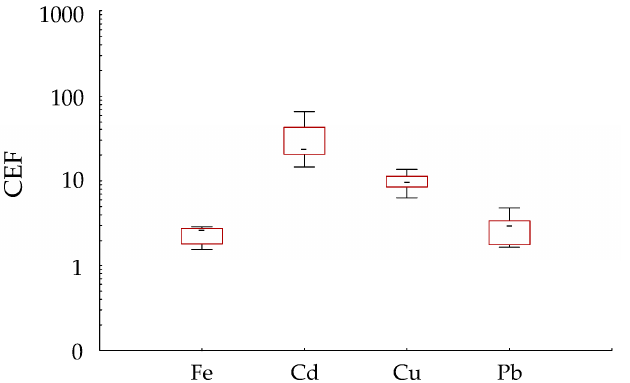
Figure 4. Box-and-whisker plots of CEFs (values reported in logarithmic scale) for metals in the PM 10 collected at Faraglione Camp (Terra Nova Bay, Antarctica) between December 2013 and February 2014. The central horizontal line is the median value, and the bottom and the top of each box are the 25th and 75th percentiles. The upper and lower horizontal bars indicate the 5th and 95th percentiles of the data.